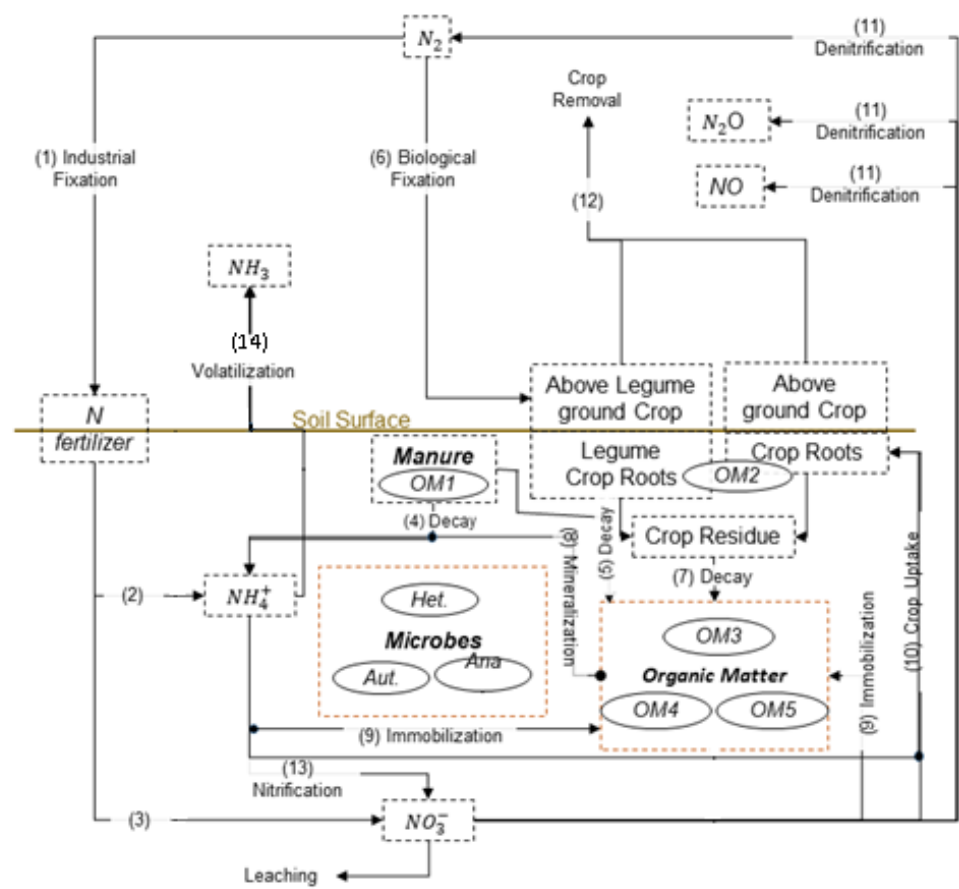
Figure 1. Generic nitrogen cycle in agriculture setting